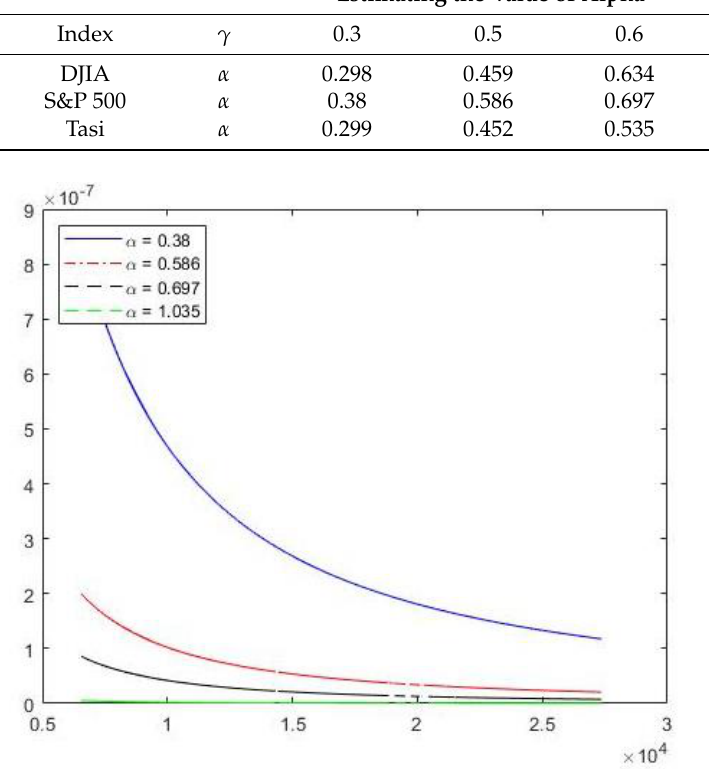
Figure 3. The shape of the tails of the S & P 500 daily data at various alpha values (see Table 1) with η = 0, m = 0 and σ = 1, shows that the data has a heavier tail when α